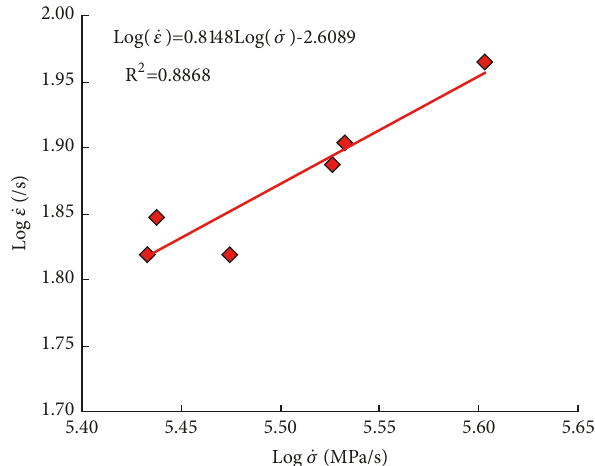
Figure 5: Relationship between the logarithm of loading rate and the logarithm of strain